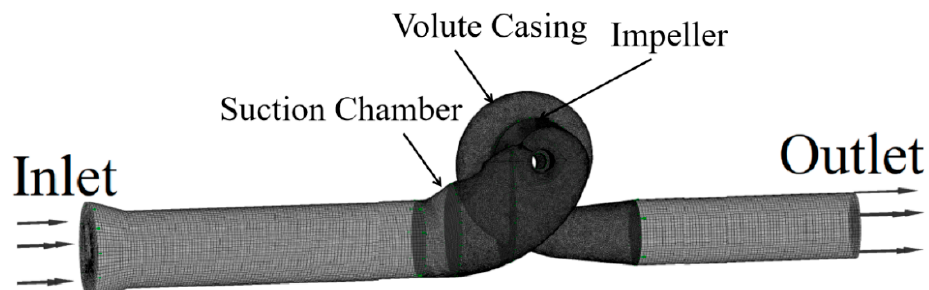
Figure 3. Grid of the calculation model.